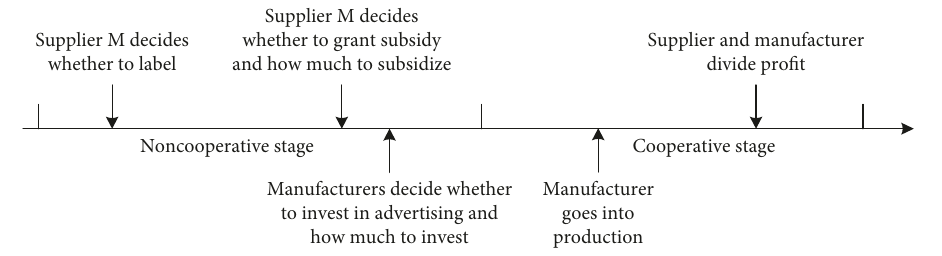
Figure 7: Decision sequence of players in